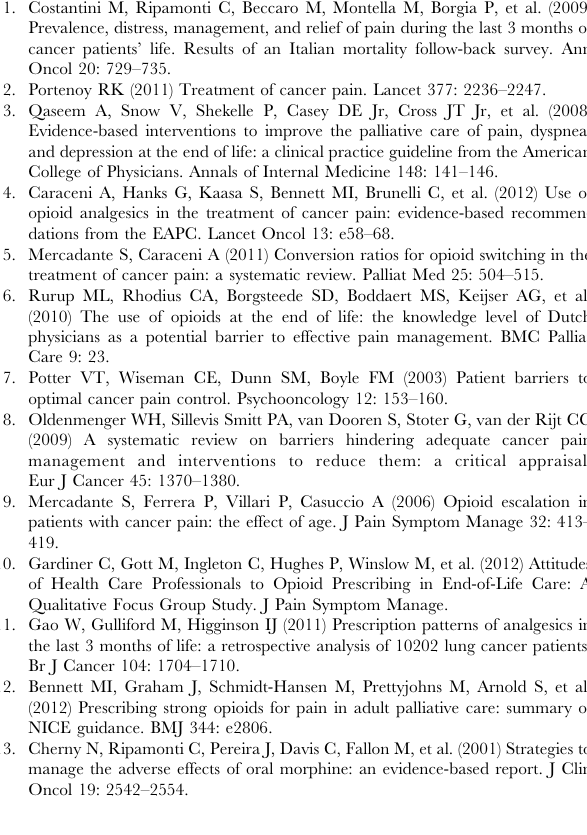
Table S2 Crude prevalence ratios (CPR, 95%CI) and adjusted prevalence ratios (APR, 95%CI)* of factors associated with the number of type of strong opioids a patient received in the last three months of life (N= 8,712), based on patients with no referral record during the last three